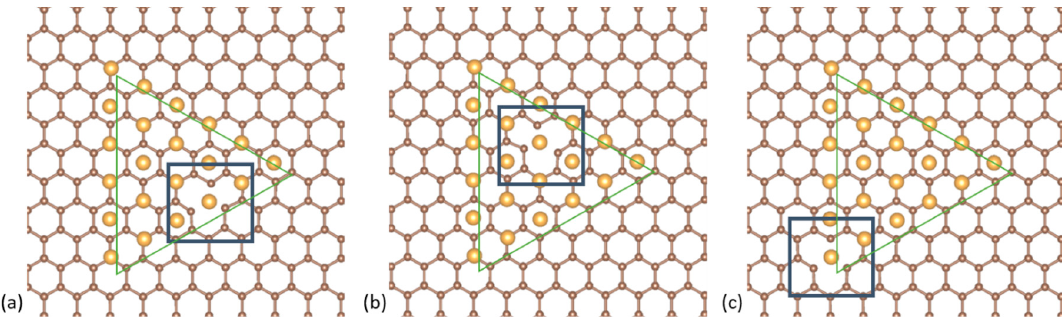
Figure 4. Cross-sections of the top-down projection for the three different positionings of the vacancy under the triangular (111) facet of the NPs: ( a ) under one edge of the triangle, ( b ) near the center of the triangle and ( c ) under a vertex of the triangle (relaxed models).